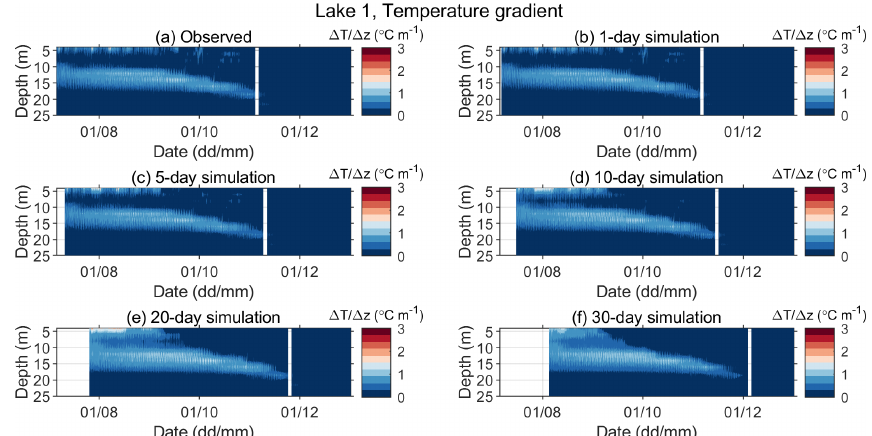
Figure A3. Observed (a) and predicted (b–f) vertical gradients of water temperature for Lake 1 for different simulation lengths in the period between 6 July and 31 December 2019.